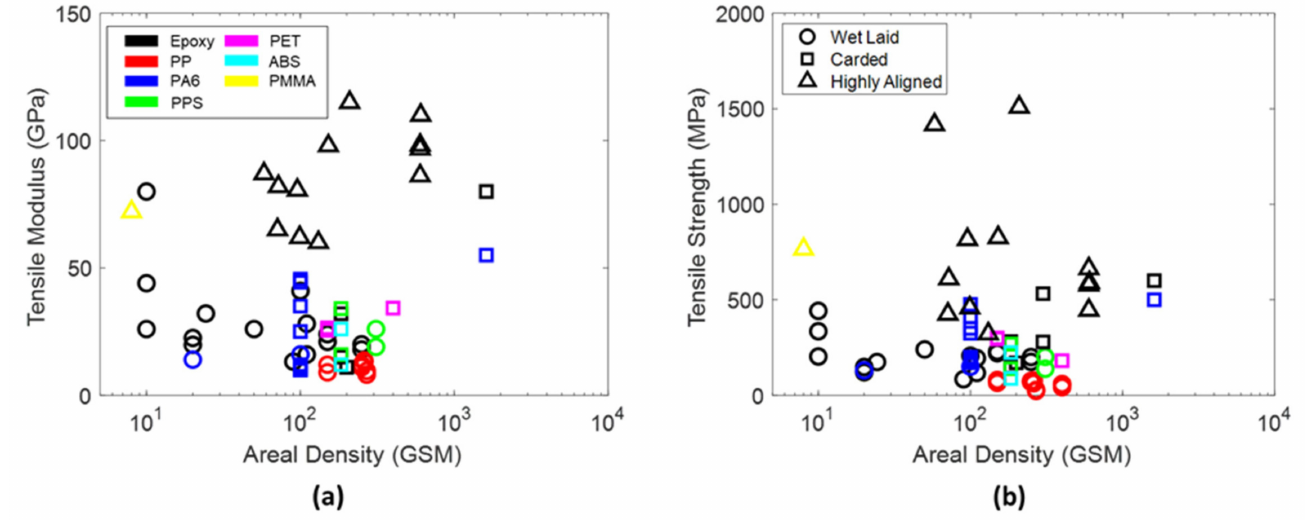
Figure 11. Impact of areal density on the tensile modulus ( a ) and strength ( b ) of recycled carbon fiber